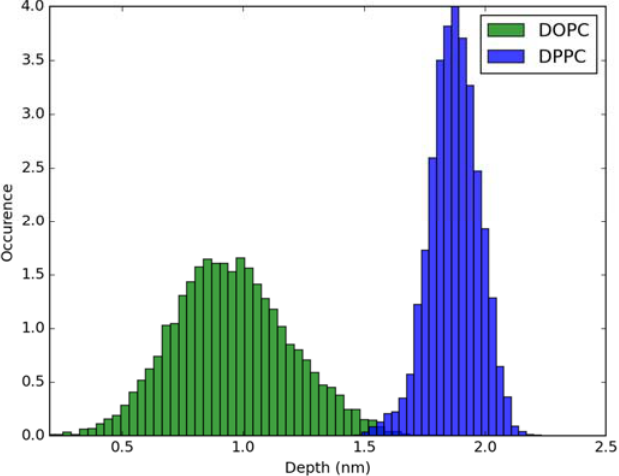
Figure 3. Histogram of penetration depth of Laurdan fluorophore in the ground state into lipid bilayers.